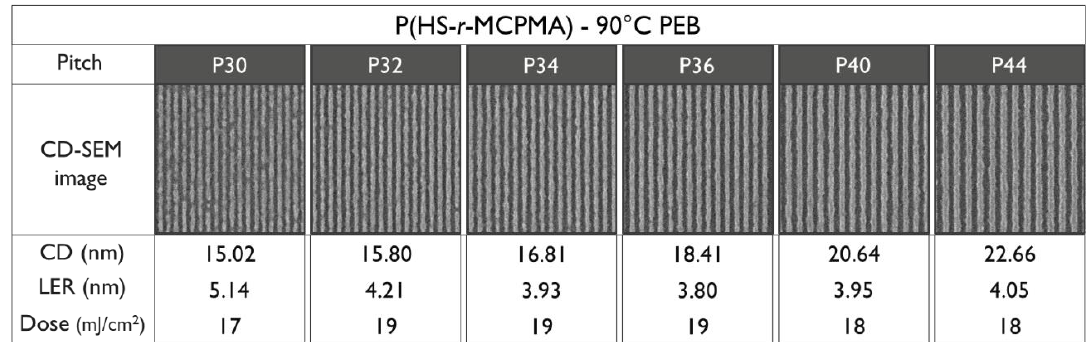
Figure 8. Patterning performance of the P(HS- r -MCPMA) polymer-based resist at 90 °C post-exposure bake (PEB).